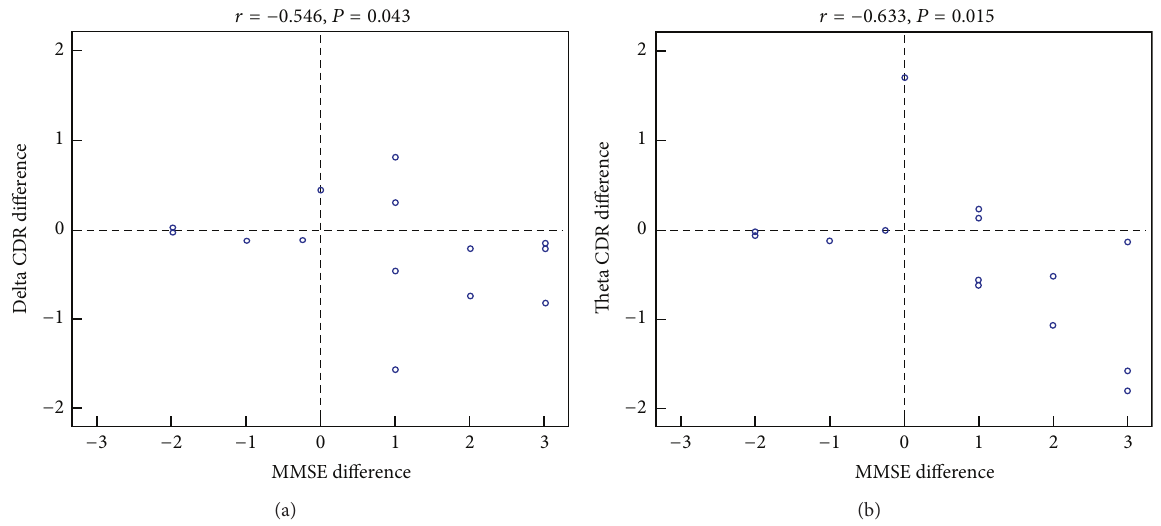
Figure 3: Visualization of the negative correlation of delta ( 𝑟 = −0.546 , 𝑃 = 0.043 ) (a) and theta ( 𝑟 = −0.633 , 𝑃 = 0.015 ) (b) bands among the MMSE score post- to pre-difference of each participant and the CDR post- to pre-difference of PCu/PCC activity that was statistically significant at 𝑃 < 0.05 ,